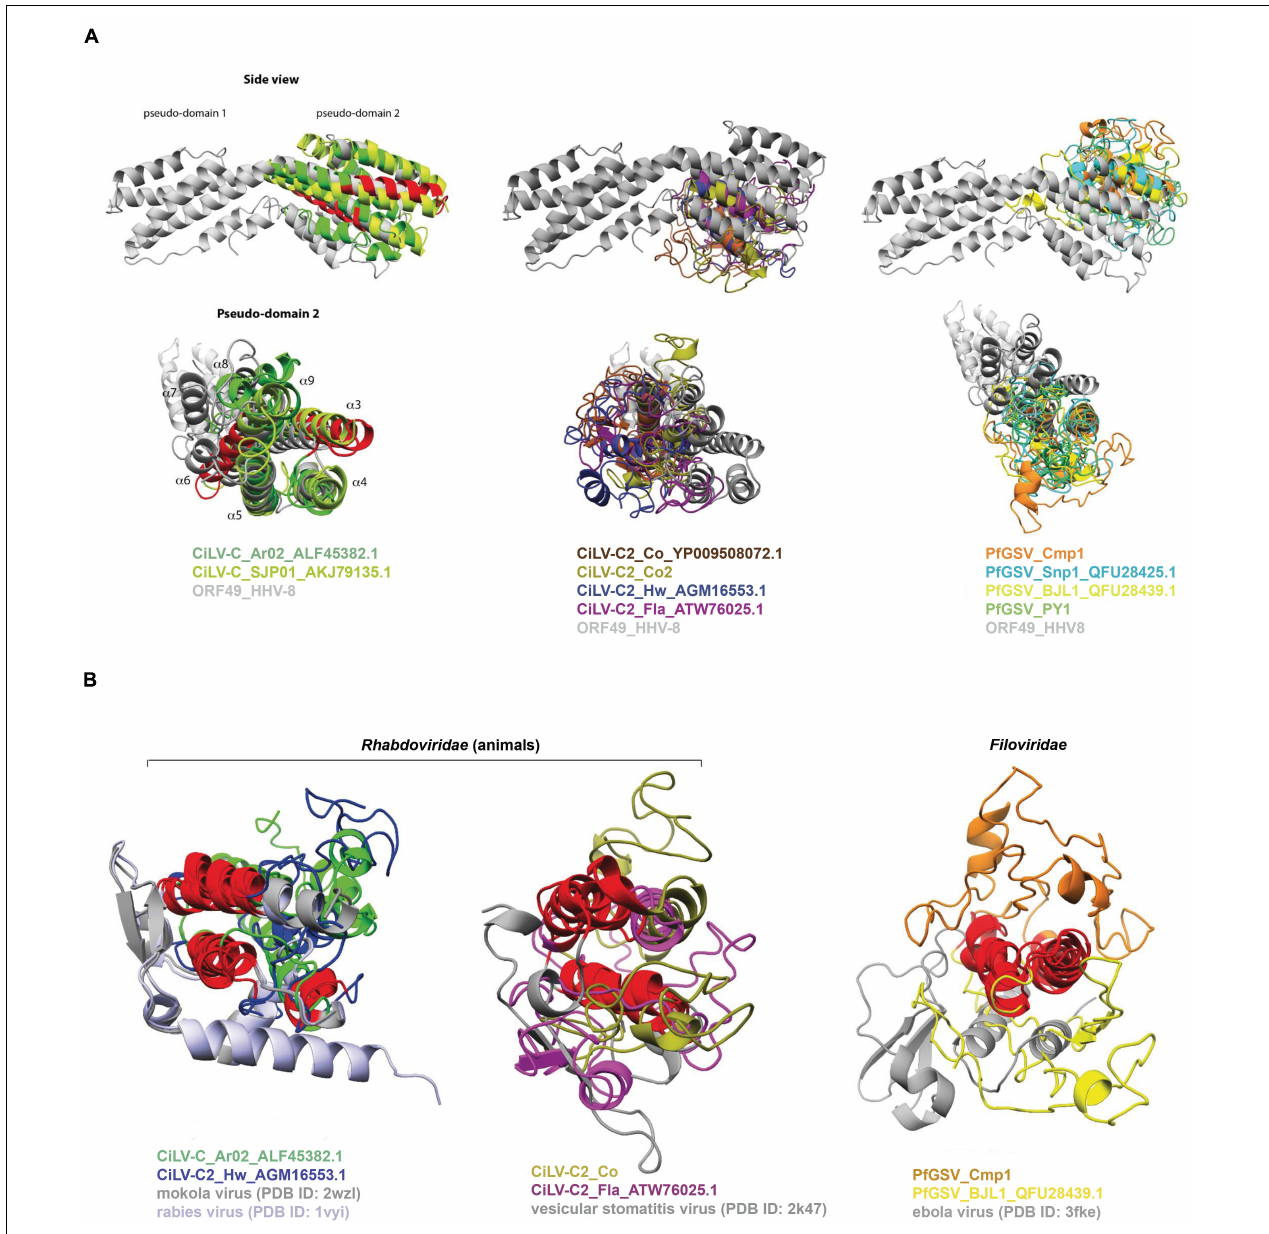
FIGURE 6 | 3D structural similarities between P15 and (A) the protein ORF49 from the human gammaherpesvirus 8 (ORF49_HHV-8, PDB ID: 5ipx) and (B) the rhabdoviruses rabies virus (PDB ID: 1vyi) and vesicular stomatitis Indiana virus (PDB ID: 2k47), and the filovirus Zaire ebolavirus (PDB ID: 3fke). Multiple structural alignments were done with the PDBeFold method. The conserved sequential motif {[FY]-L-x(3)-[FL]-H-x [LIV]-S-C-x-C-x(2)-C-x-G-x-C} is displayed in red. Structure figures were prepared using PyMOL (Delano,